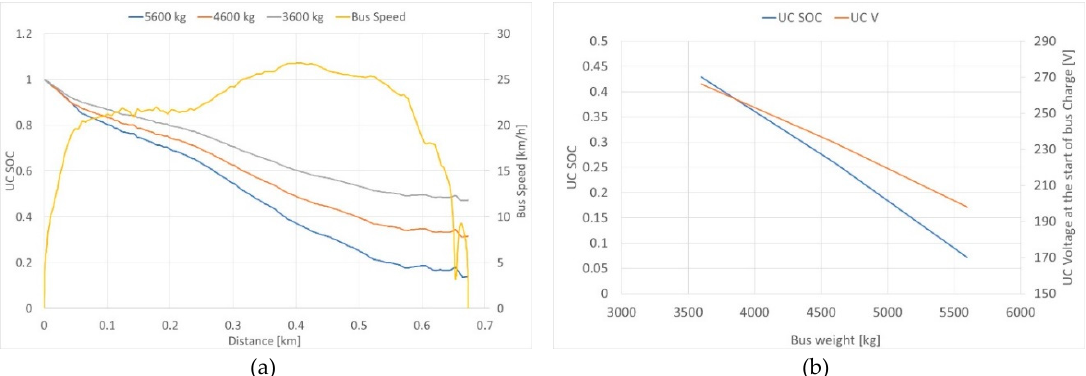
Figure 8. ( a ) Vehicle speed profile and state of charge (SOC) for different bus weights, ( b ) voltage of the supercapacitor tank and related SOC.